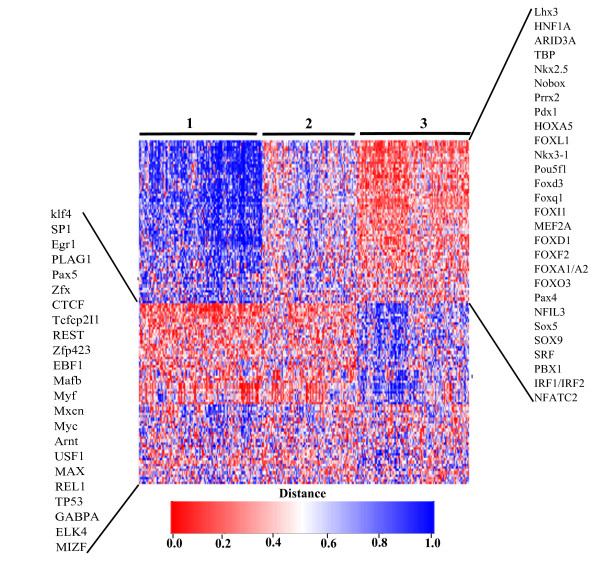
Heatmap of transcription factor binding affinities for all identified miRNA promoters. All identified miRNA promoters are clustered based on their affinity profiles for the 130 JASPAR core vertebrate factors. Cluster 3 is enriched in intronic promoters, while cluster 1 is enriched in host gene promoters. The transcription factors highlighted in the box on the right side are those with a high affinity for intronic promoters, which are also identified as significantly enriched by TRAP. The transcription factors in the box on the left side are those with a high affinity for host gene promoters, also reported by TRAP as significantly enriched in the same promoter class.